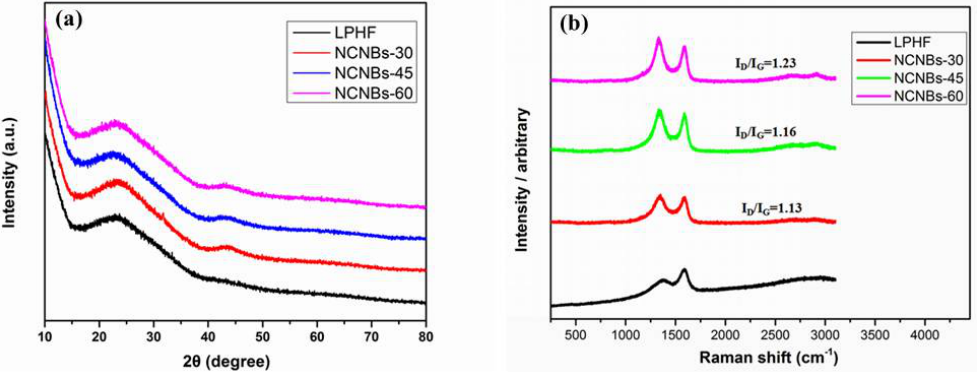
Figure 3. ( a ) X-ray powder diffraction (XRD) patterns of and ( b ) Raman spectraofall NCNBs.